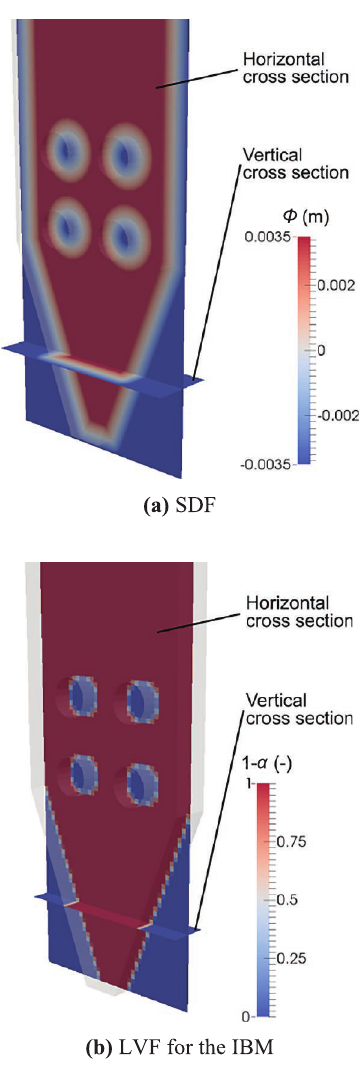
Fig. 6 Wall boundary model in a gas-solid flow